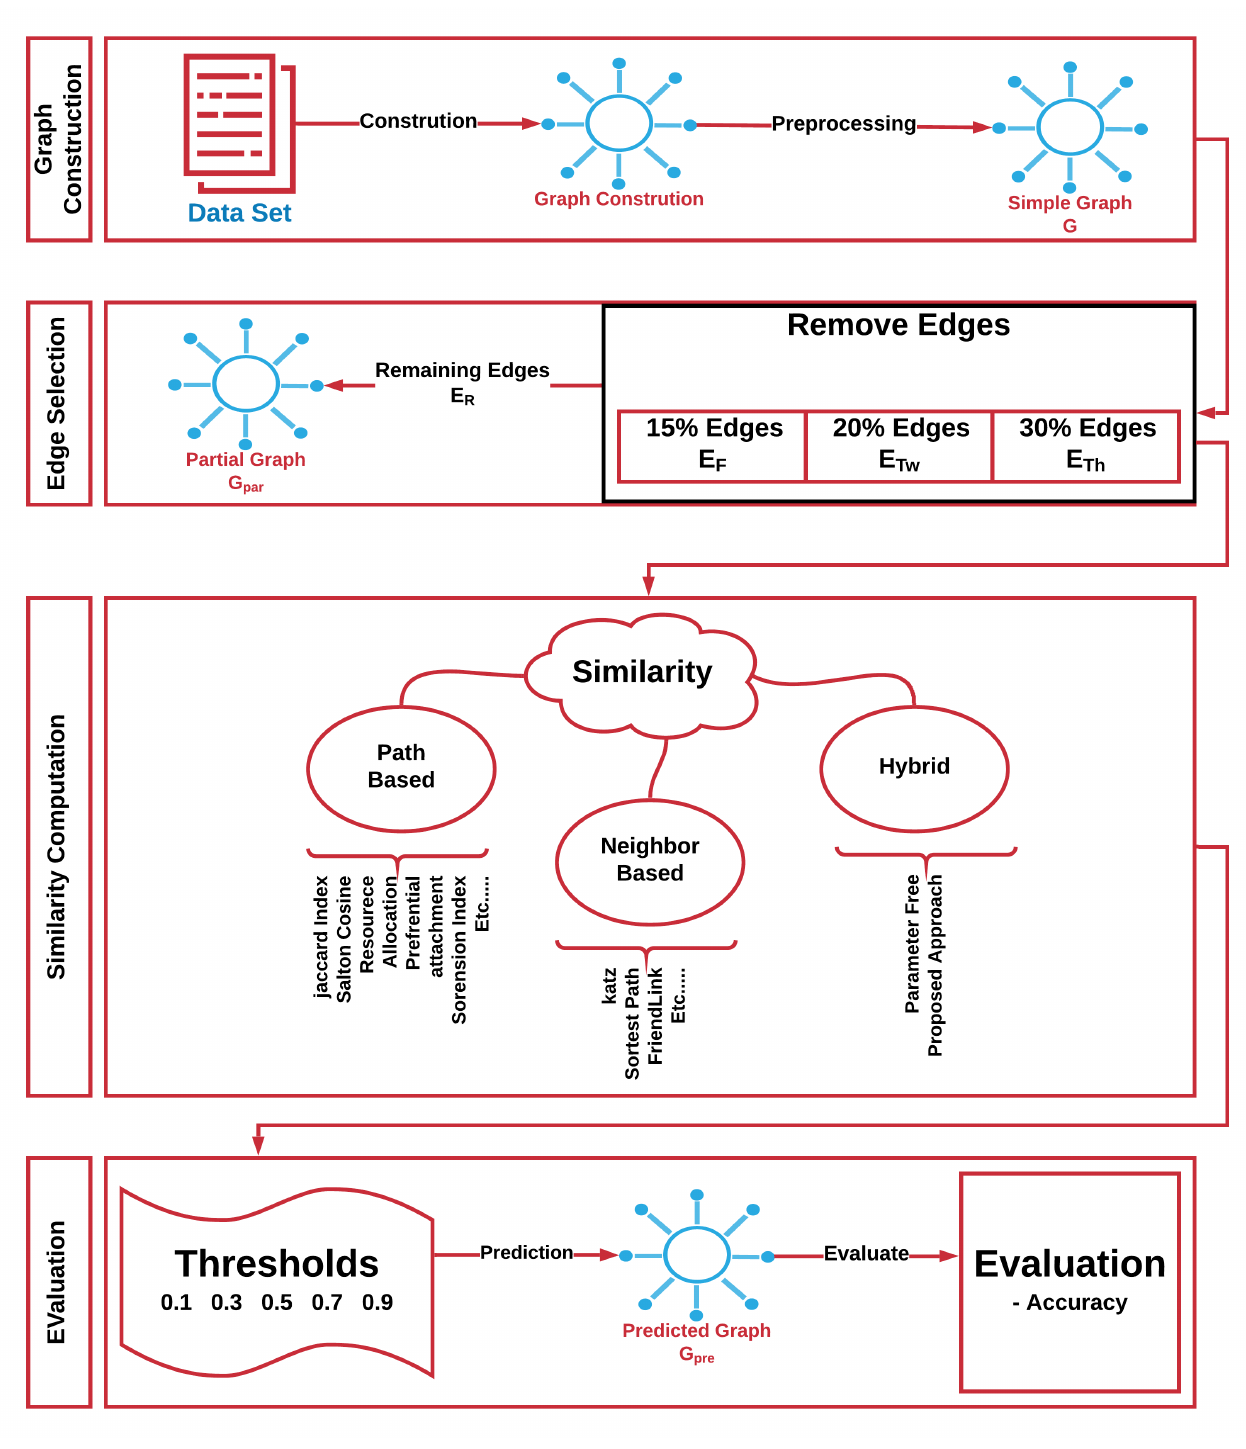
Figure 3. Research Methodology